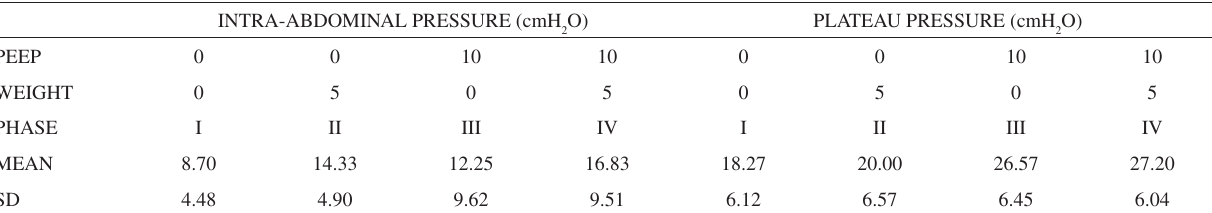
Table 1 - Intra-abdominal and plateau pressures for each phase of the protocol INTRA-ABDOMINAL PRESSURE (cmH 2